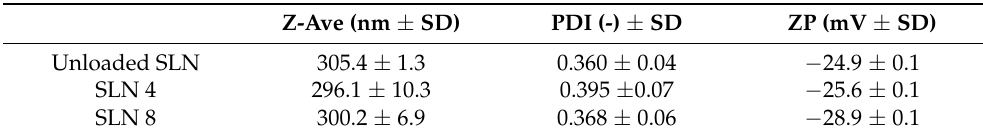
Table 2. Dimension (Z-Ave), polydispersity index (PDI) and zeta potential (ZP) of unloaded SLN, SLN4 and